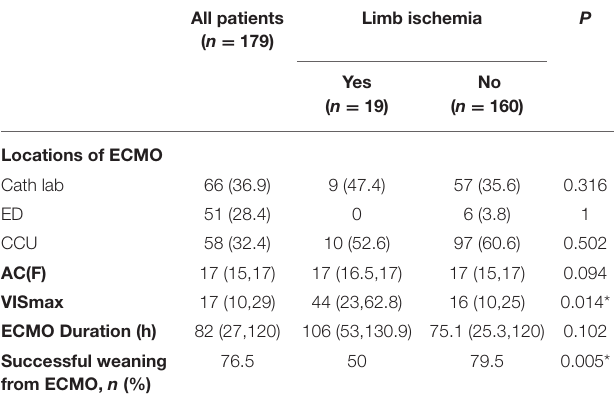
TABLE 2 | Comparison of V-A ECMO related characteristics. All patients ( n = 179)